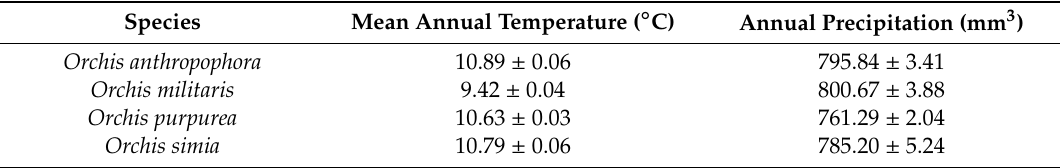
Figure 4. Heatmap of variable importance for the ecological niche model of each Orchis species. Red and orange cells indicate a higher dependence of the species’ occurrence on the corresponding habitat variable and blue cells indicate low dependence. The environmental variables used are mean annual temperature, annual precipitation, elevation, bedrock type, and the first two axes of a principal component analysis of a dataset of physical soil characteristics (SP1, SP2) and of a biochemical soil dataset (SB1, SB2). Table 3. Mean values of the climatic variables for each Orchis species habitat.